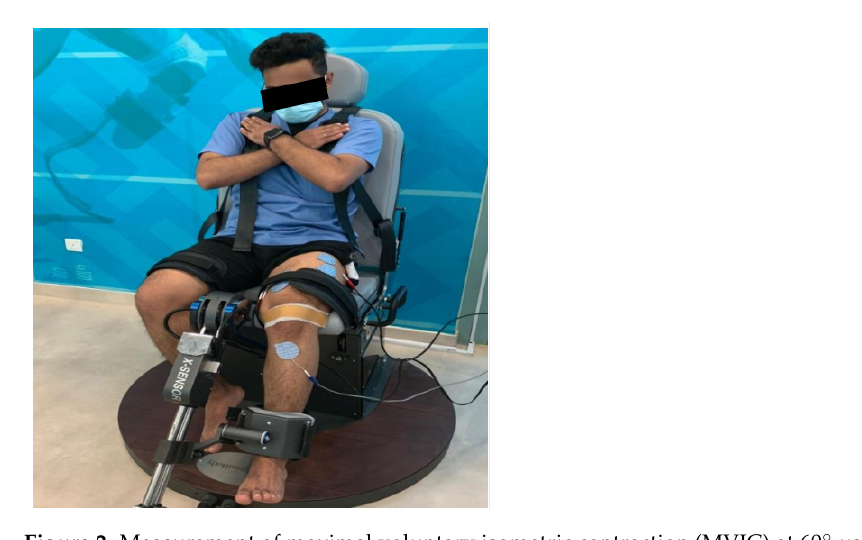
Figure 2. Measurement of maximal voluntary isometric contraction (MVIC) at 60 ◦ using ISOMOVE isokinetic